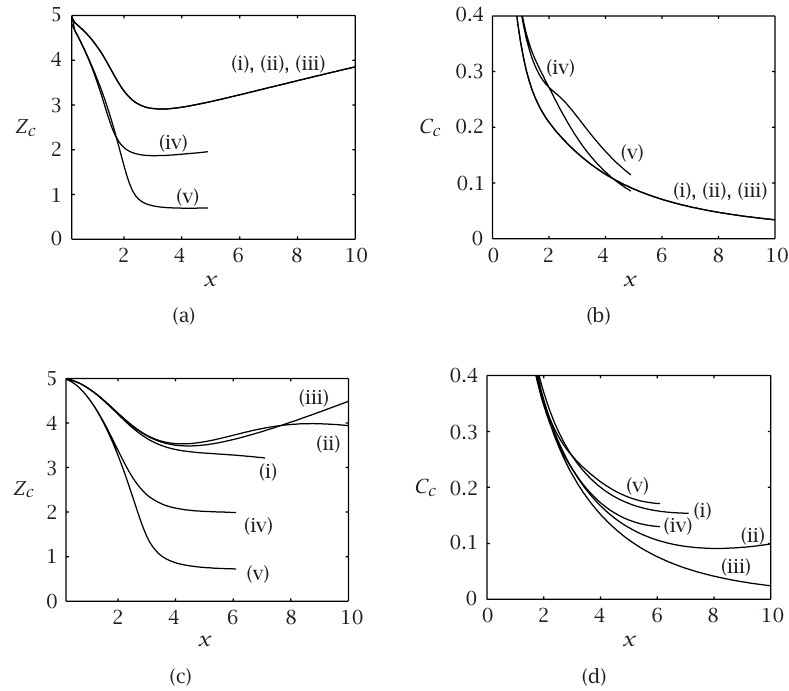
Figure 6.4 . A sample of the data obtained for the curve of extensive pollution of dust in the (x,z) plane for different values of time and two values of b when the source is situated at one point; (a), (b) for b = 0 and (c), (d) for b = 3 . 0. Figures 6.4(a) and 6.4(c) represent the variations in height of the point with horizontal distance x while (b) and (d) represent the profiles of the concentration as a function of x when h = 5 . 0. The curves refer to the sets of data: (i) t = 5 . 0, ν = 0 . 5, z o = 0 . 5, (ii) t = 10 . 0, ν = 0 . 5, z o = 0 . 5, (iii) t = 50 . 0, ν = 0 . 5, z o = 0 . 5, (iv) t = 5 . 0, ν = 1 . 5, z o = 0 . 5, and (v) t = 5 . 0, ν = 0 . 5, z o = 0 .